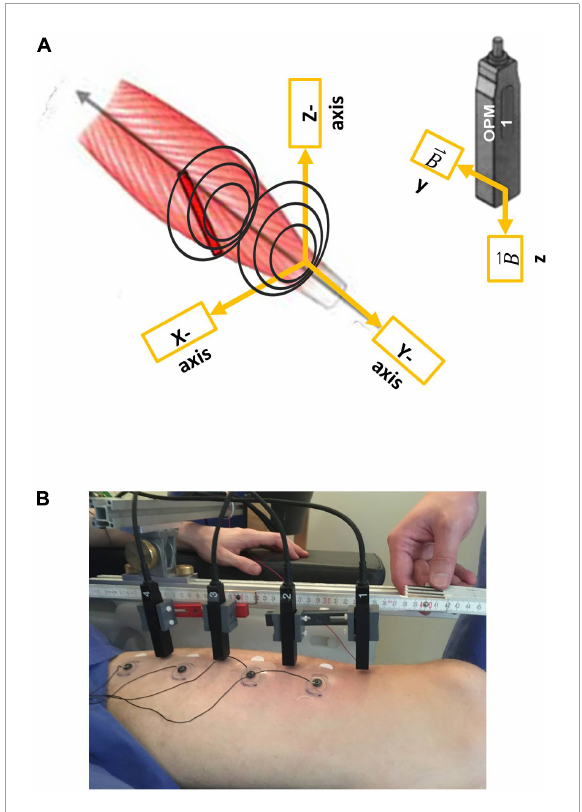
FIGURE1 Illustration of the vectorial components of optically pumped magnetometers (OPMs), respectively, to the rectus femoris muscle (A) and the measurement setup (B) . Note that OPM 1–4 were placed from the distal (OPM 1) to the proximal (OPM 4). In addition, surface electrodes (sEMG 1–4) were placed in between the